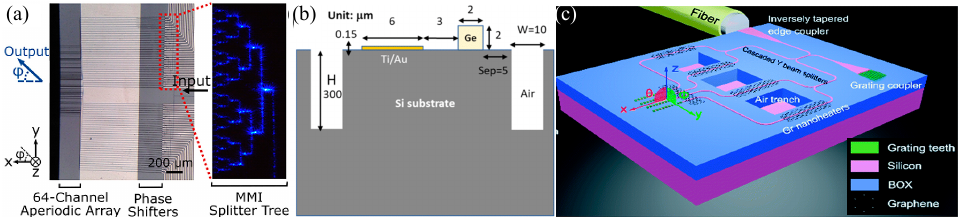
Figure 13. Some typical thermal crosstalk-suppressed structures for OPAs. ( a ) An OPA with a fan-in/fan-out section for thermal crosstalk suppression. Reprinted with permission from [41] © The Optical Society. ( b ) Cross-section of a TO phase shifter with deeply etched trenches. Reproduced from [72] published by IEEE, 2019. ( c ) An OPA with both a fan-in/fan-out section and deeply etched isolation trenches. Reproduced from [75] published by The Royal Society of Chemistry, 2018.